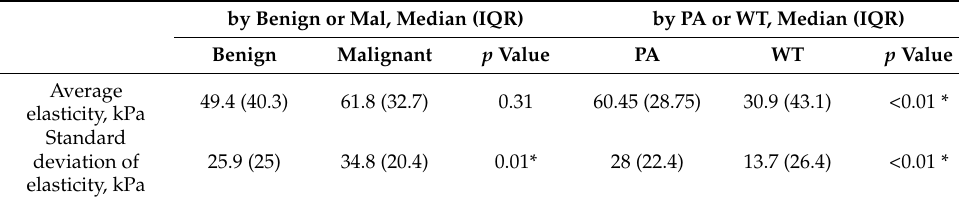
Table 2. Comparison of the average and standard deviation of elasticity. by Benign or Mal, Median (IQR) by PA or WT, Median (IQR)